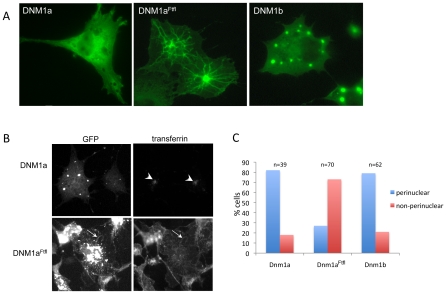
DNM1 localization and endocytosis in COS-7 cells.(A) DNM1 isoform localization in COS-7 cells over-expressing DNM1 isoform constructs. Left is wildtype, middle is DNM1aFtfl and right is DNM1b. Note the tubulation in the mutant expressing cells. (B) Transferrin endocytosis and localization in COS-7 cells overexpressing DNM1 isoform constructs. Left panels show DNM1 GFP fluorescence in COS-7 cells containing wildtype or DNM1aFtfl; right panels show TRITC-transferrin uptake and localization in COS-7 cells containing wildtype or DNM1aFtfl -GFP. The arrowheads in the top right picture indicate the normal perinuclear accumulation of transferrin. The arrows in the bottom right picture indicate one point of co-localization between DNM1aFtfl and transferrin. (C) Quantification of transferrin localization in COS-7 cells overexpressing DNM1 isoform constructs. Transfected cells were determined to have transferrin localized to the region adjacent to the nucleus in a manner similar to non-transfected cells or to have not taken up transferrin at all or to have an abnormal localization of transferrin.